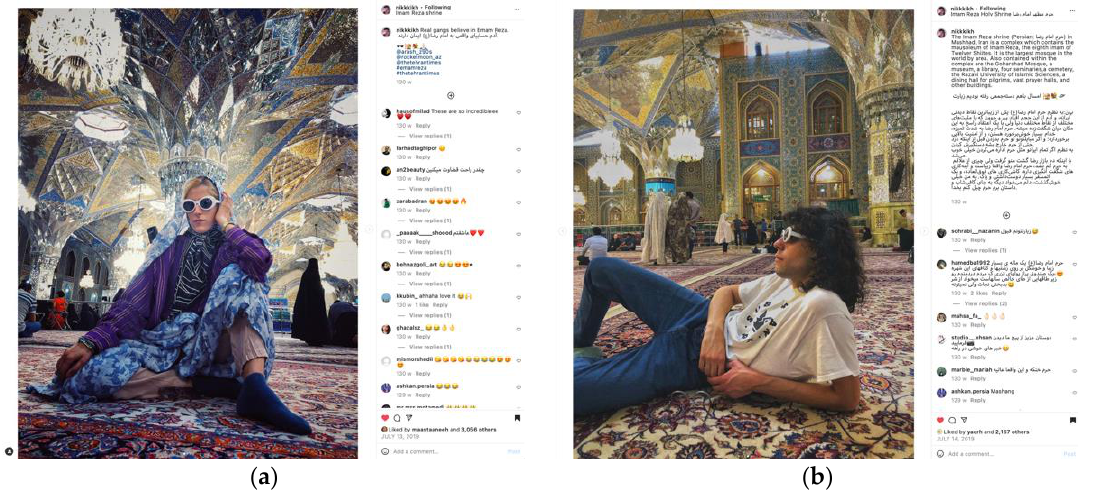
Figure 5. posing in the holy shrine of Imam Reza (Used with permission): ( a ) source: Figure 5. Posing in the holy shrine of Imam Reza (Used with permission): ( a ) source: https://www. https://www.instagram.com/p/Bz2cbbDoEHq/?utm_source=ig_web_copy_link (accessed on 17 instagram.com/p/Bz2cbbDoEHq/?utm_source=ig_web_copy_link (accessed on 17 May 2021) ( b ) May 2021) ( b ) source: https://www.instagram.com/p/Bz5YO3hI5JZ/ (accessed on 17 May 2021) source: https://www.instagram.com/p/Bz5YO3hI5JZ/ (accessed on 17 May